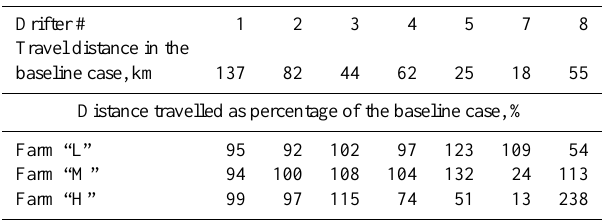
Fig.8. Effect of the farm shape on the main parameters of the flow. Left panel- kinetic 667 energy per unit area (J/m 2 ); middle panel- mean extracted power in W/m 2 ; right panel 668 - simulated trajectories of Lagrangean drifters drogued at 22.5 m depth, for a farm 669 Farm extended along the meridian. The rated capacity of the farm (i.e. the number of 670 turbines) is the same as for high-rated circular farm shown in Figs (5)-(7).The shape 671 of the farm is shown by a shaded oval on the right panel. 672